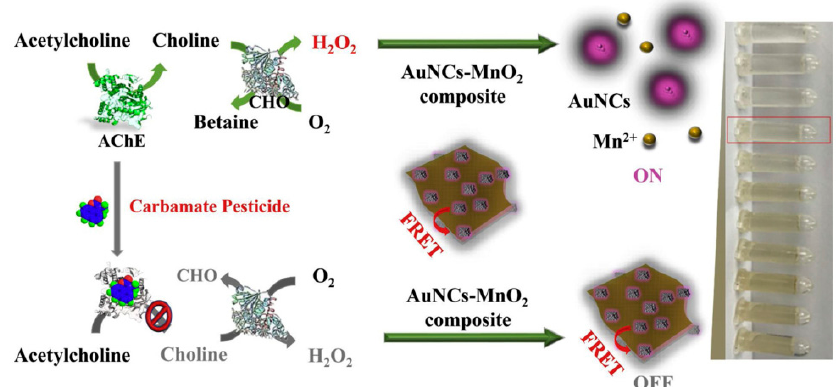
Figure 8. Schematic illustration of the dual-signal system for detecting cetylcholine and its derivatives. Adapted with permission from Reference [41] Copyright (2019) Elsevier.